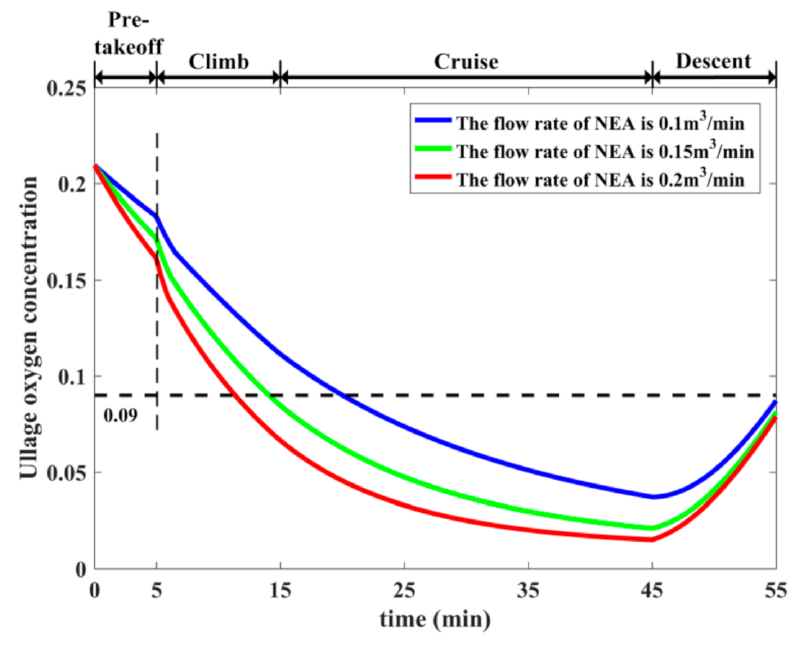
Figure 8. The ullage oxygen concentration regarding the volume inflow rate of NEA, with the ground-based inerting duration of 5 min, k = 30% and the fuel load of